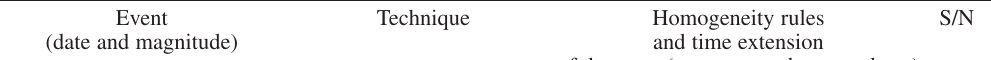
Table I. Seismic events which have been studied by applying the RST approach: the used variable V( r,t ), the sensor, the length (years) and homogeneity rules (months of the year, time of the day) which have been applied to build the historical data-set (used to compute reference images µ V and σ V ) and the minimum S/N ratio of TIR anomalies are indicated, together with the